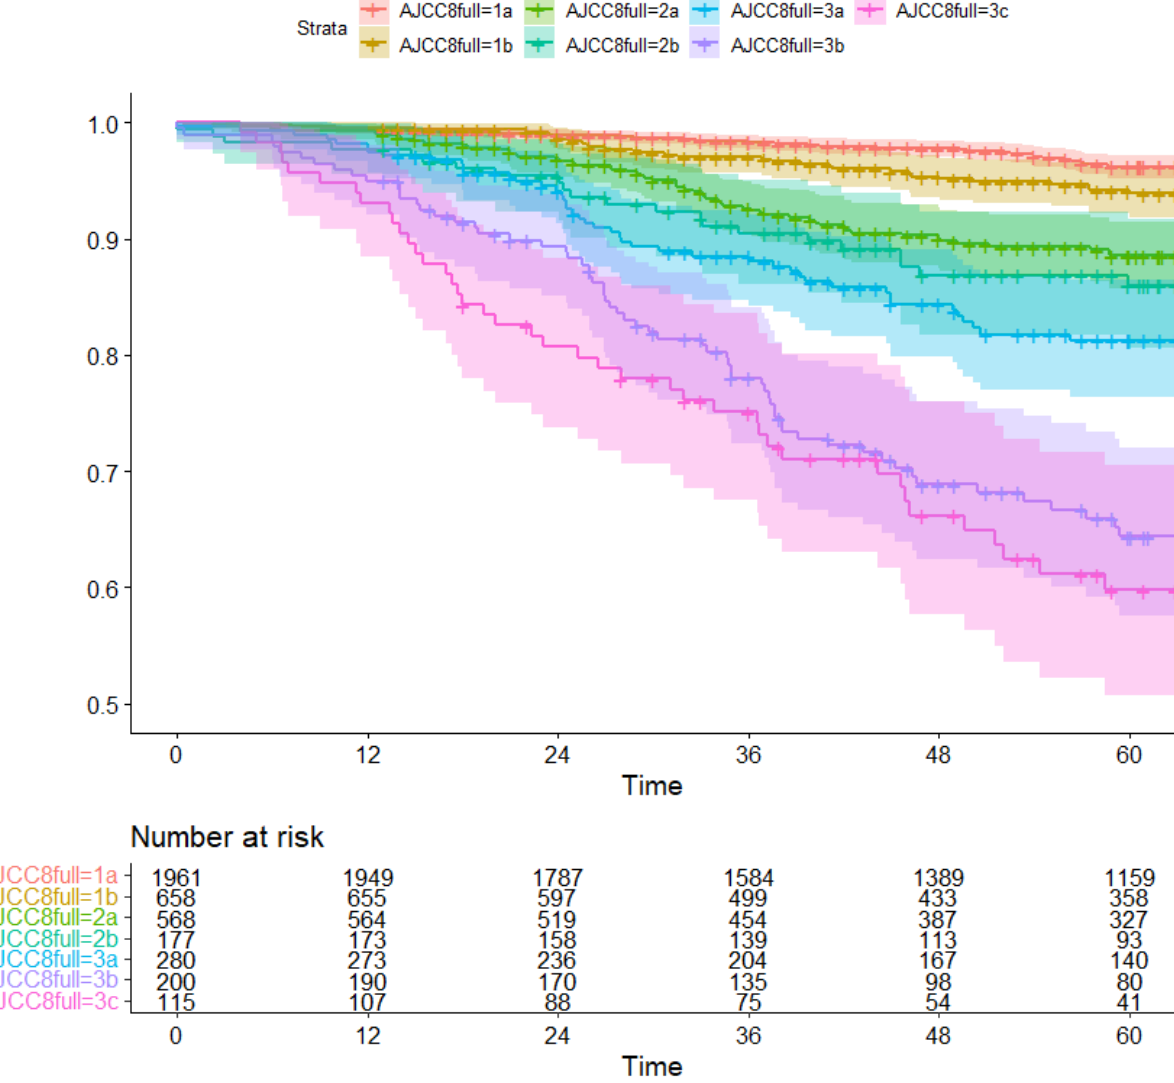
Figure 4. Kaplan Meier survival curve for overall survival (death from any cause) by AJCC8 stage (time in months).